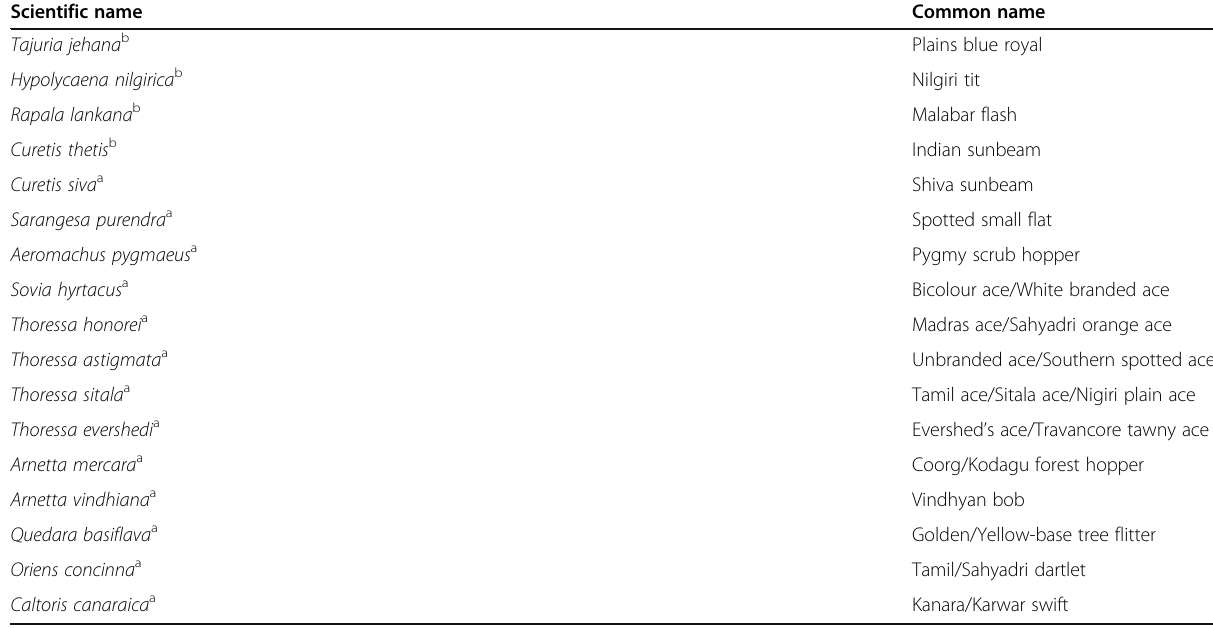
Table 2 Species recorded as endemic to the Western Ghats, Sri Lanka and peninsular India